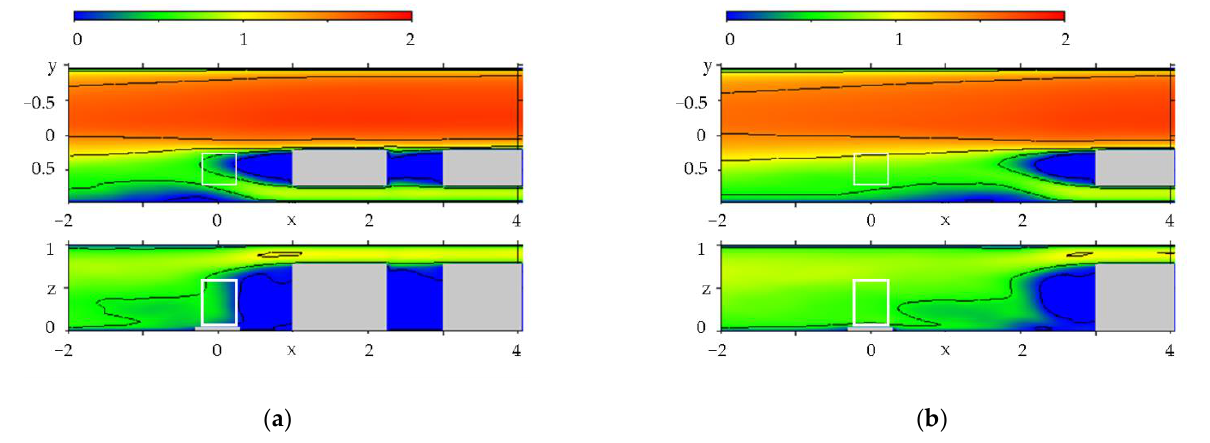
Figure 21. The distribution of the x -direction velocity − u/Um, R = 0.2: ( a ) ℓb = 1 m; ( b ) ℓb = 3 m. According to this research, nearly all backlayering length with obstacles could be ap- proximated by the approximation formula of Pattern A. If the blockage ratio was lower than 0.1 when a single lane had an obstacle, the approximation formula of Pattern B was applicable. However, when the fire source was close to the obstacle, the backlayering length was unstable and it could not be represented by the approximation formulae of this study.